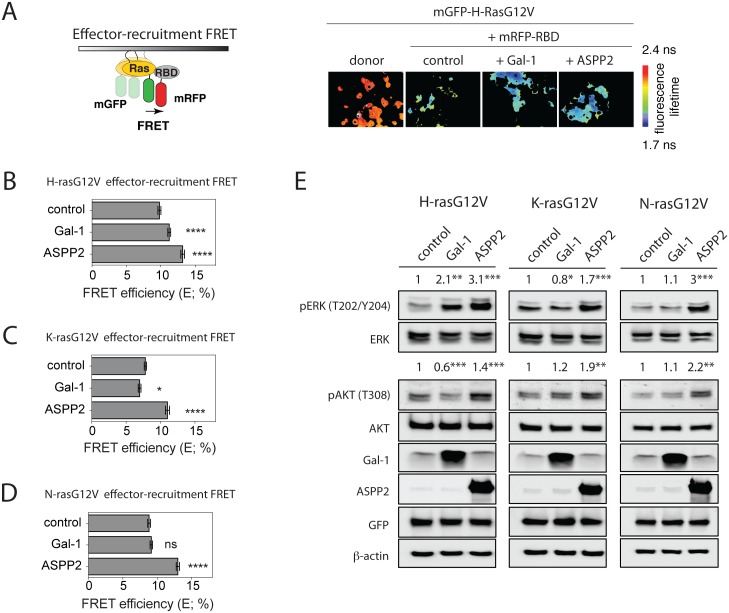
ASPP2 increases oncogenic H-ras, K-ras and N-ras-effector-recruitment, as well as ERK- and AKT-signalling.(A) Left, scheme explaining effector-recruitment FRET analysis in HEK cells. Right, examples of FLIM-FRET images of HEK cells from the different FRET samples as indicated. (B-D) Effector-recruitment FRET analysis in HEK cells coexpressing (B) mGFP-H-rasG12V, (C) mGFP-K-rasG12V or (D) mGFP-NrasG12V and mRFP-RBD from C-Raf. The effect of Gal-1 or ASPP2 expression on effector-recruitment FRET was compared to control samples. (E) Representative Western blots from HEK cells expressing mGFP-H-rasG12V (left), K-rasG12V (middle) or N-rasG12V (right) without or with Gal-1 or ASPP2. Statistical significance of differences between controls and treated samples was examined using one-way ANOVA (mean ± SEM, n = 3; ns, not significant; *, p<0.05, **, p< 0.01, ***, p<0.001, ****, p< 0.0001).